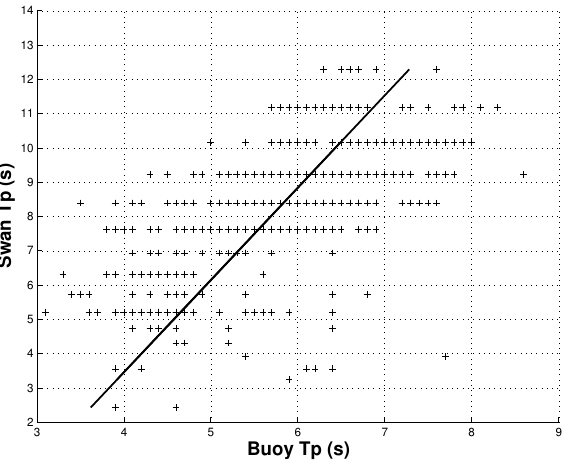
Fig. 4. Scatter diagram of recorded vs. SWAN H s at Carrara. The storm events considered in the analysis are listed in Tab.1